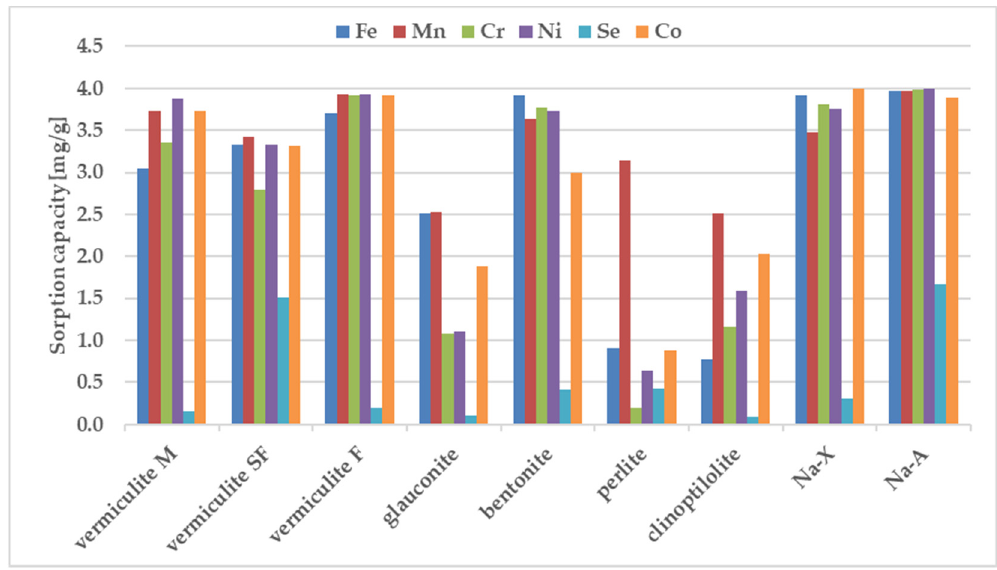
Figure 2. The sorption capacity of the investigated sorbents for metal ions, estimated in batch study. Initial ion concentration c 0 = 100 mg L − 1 , volume of solution = 12 mL, mass of zeolite = 0.3 g, contact time = 1 h. The measurements were conducted at the room temperature (23 ± 0.2 °C).